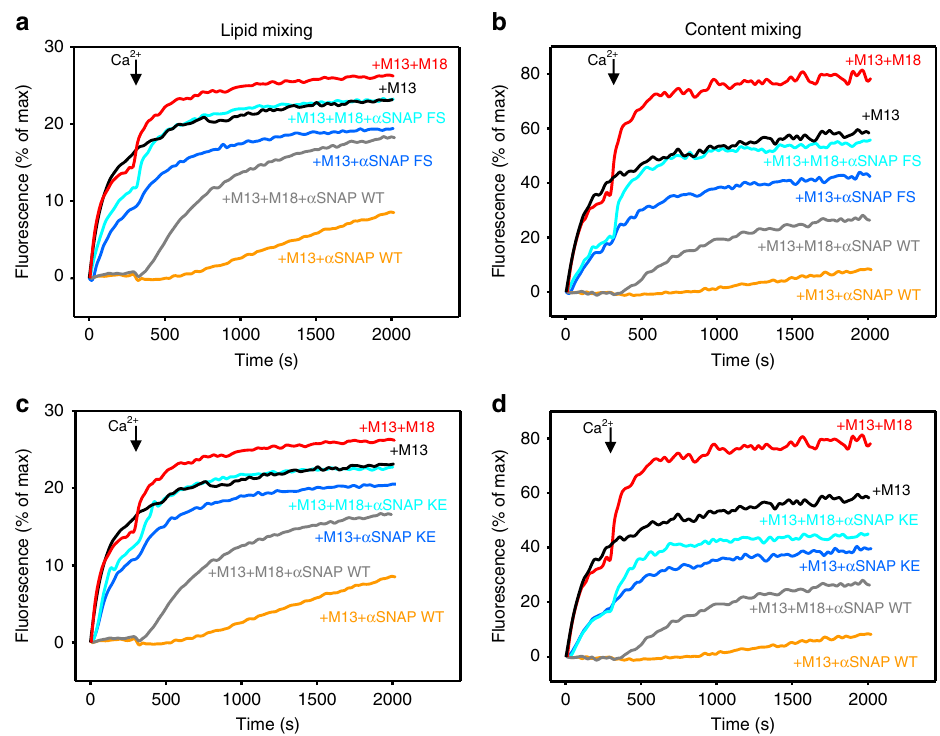
Fig. 3 Binding of α SNAP to the SNAREs and membranes is critical for its inhibitory activity. a – d Lipid mixing ( a , c ) between V- and T-liposomes was monitored from the fl uorescence de-quenching of Marina Blue lipids and content mixing ( b , d ) was monitored from the increase in the fl uorescence signal of Cy5-streptavidin trapped in the V-liposomes caused by FRET with PhycoE-biotin trapped in the T-liposomes upon liposome fusion. Assays were performed in the presence of 0.5 µ M M13C 1 C 2 BMUNC 2 C (M13) with or without 1 µ M Munc18-1 (M18) and with 2 µ M WT or mutant α SNAP ( α SNAP FS mutant in a , b ; α SNAP KE mutant in c , d ). Experiments were started in the presence of 100 μ M EGTA, 1 µ M excess of SNAP-25, and 5 μ M streptavidin, and the Ca 2 + (600 μ M) was added at 300 s. Source data are provided as a Source Data fi